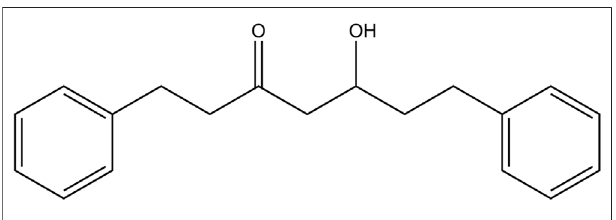
FIGURE 1 | The chemical structure of